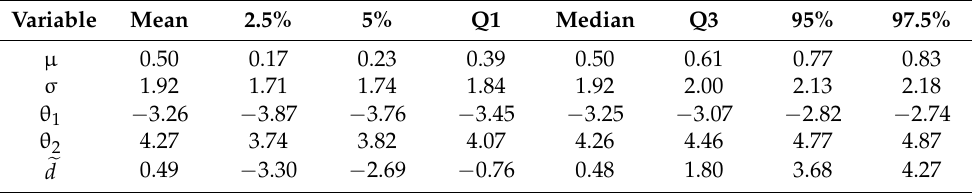
Figure 3. The top panel shows the posterior distribution of µ , σ , and ( µ , σ ) from left to right. The bottom panel comprises the posterior distribution of θ 1 and θ 2 as well as the posterior predictive distribution of a future difference (from left to right; output from Supplemental Material Code S3). Table 2. Mean values; first, second, and third quartiles; and 0.025, 0.05, 0.95, and 0.975 quantiles of the posterior distributions of µ , σ , θ 1 , θ 2 and of the posterior predictive distribution of a